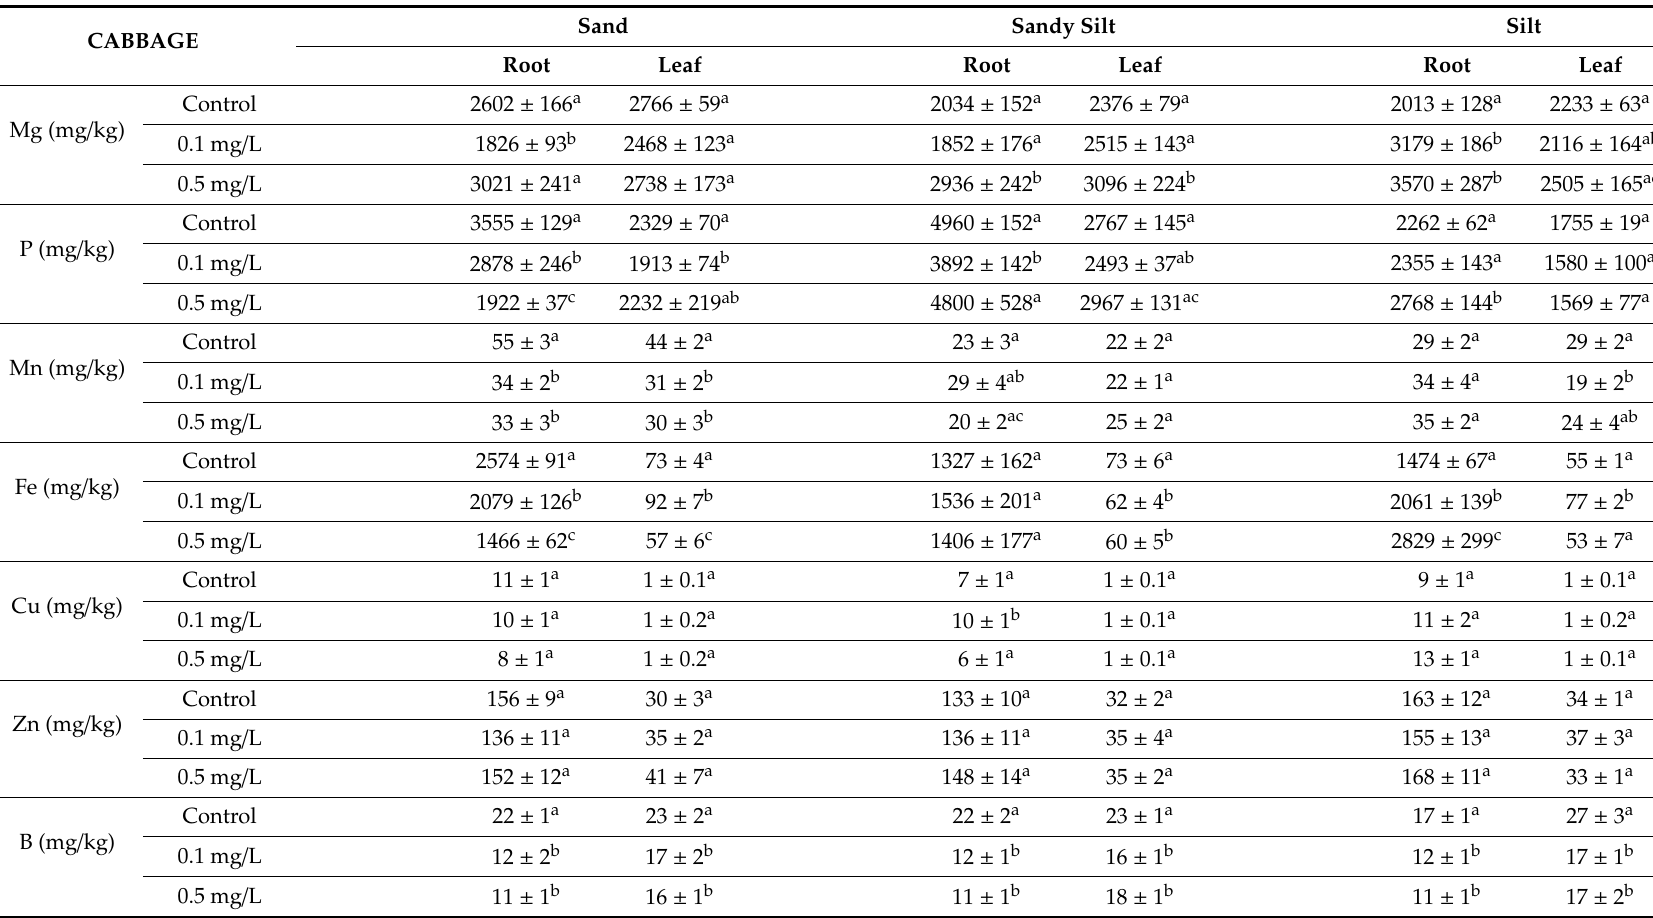
Table 5. E ff ect of iodine concentrations in the irrigation water on the concentration ( n = 3) of macro and micro-nutrients in the cases of cabbage and tomato plants. Di ff erent letters indicate significant di ff erences ( p < 0.05, Tukey’s test).